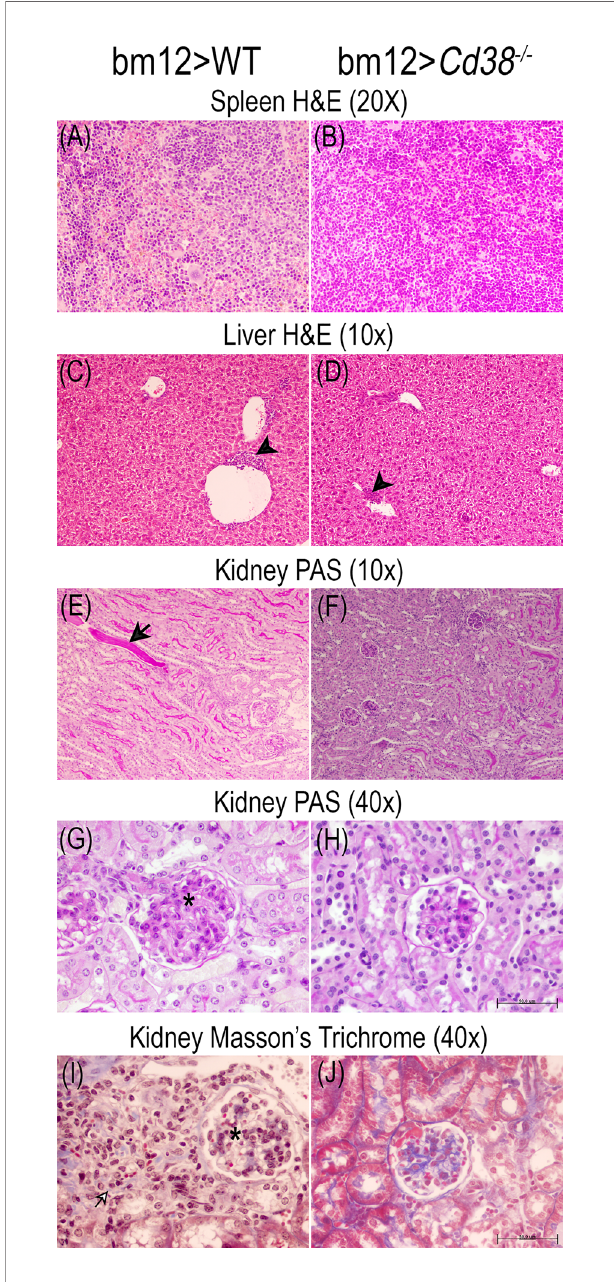
FIGURE 9 | Representative microphotographs of the histological studies performed on the spleen, liver, and kidney 3- m m sections at 2 weeks of the adoptive transfer of spleen cells from female bm12 to female WT (left panels) or to Cd38 − / − (right panels) mice. (A, B) Spleen, (C, D) liver, and (E – J) kidney. (A – D) Spleen and liver tissue sections stained with H&E. (E – H) Kidney tissue sections stained with PAS. (I, J) Kidney sections stained with Masson ’ s trichrome. Images were taken with a BH2 Olympus microscope. (A, B) ×20 magni fi cation; (C – F) ×10 magni fi cation; (G – J) 40× magni fi cation. (H, J) Scale bar: 50 m m. Note in WT cGVHD mice and Cd38 − / − cGVHD mice the presence of mild perivascular chronic in fl ammatory in fi ltrate in liver [black head arrow in (C) and (D) ]. Note in WT cGVHD mice hyaline casts in kidney [black arrow in (E) ], periglomerular chronic in fl ammatory in fi ltrate [black and white arrow in (I) ], and increased glomerular size [asterisks in (G) and (I)